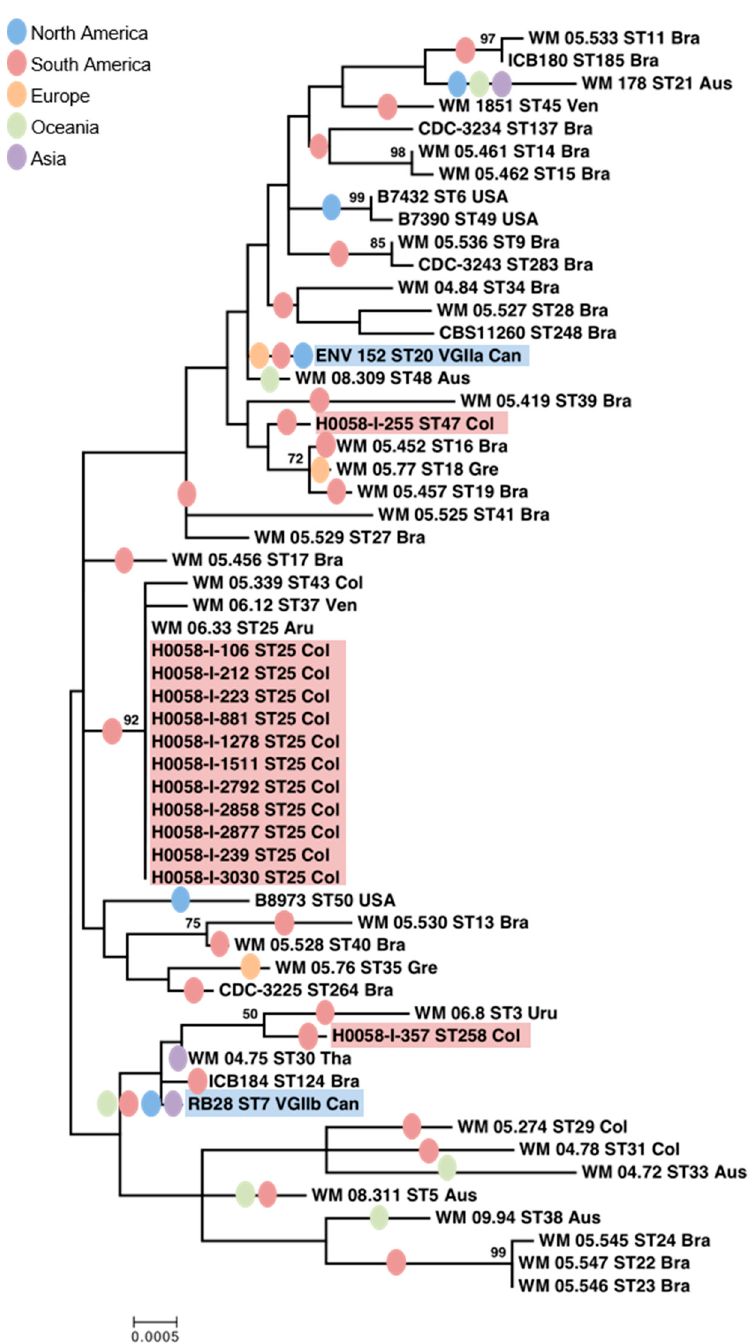
Figure 1. Dendrogram showing the genetic relationships between Cryptococcus gattii molecular type VGII isolates from Cucuta, the Vancouver Island outbreak (highlighted), and global isolates selected from previously published MLST studies [9,22,23,32–34]. The tree is based on maximum likelihood analysis of the concatenated seven ISHAM consensus MLST loci using the program MEGA 7.0.2631. Numbers on the branches indicate bootstrap values above 50. Isolates recovered in Aus: Australia, Bra: Brazil, Can: Canada, Col: Colombia, Gre: Greece, Tha: Thailand, Uru: Uruguay, USA: United States of America, and Ven: Venezuela. Ovals represent the continents where the sequence types have been previously identified.